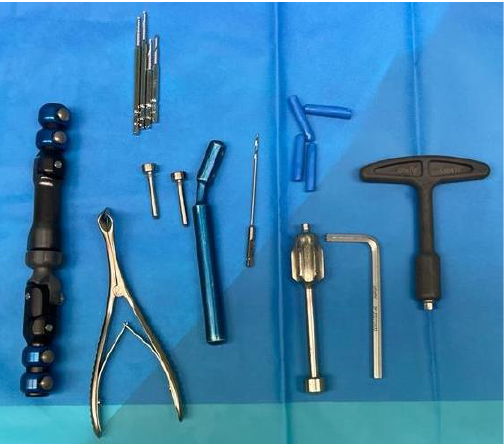
Figure 1. The complete kit of the Bridging External Fixator (BEF) for the wrist by Citieffe. First, a dorsal incision and blunt dissection were performed at the base of the second metacarpal bone. Two threaded 3 mm bicortical metacarpal pins were introduced into the metacarpal bone at an angle of inclination between 30 ◦ and 45 ◦ with respect to the horizontal plane (Figure